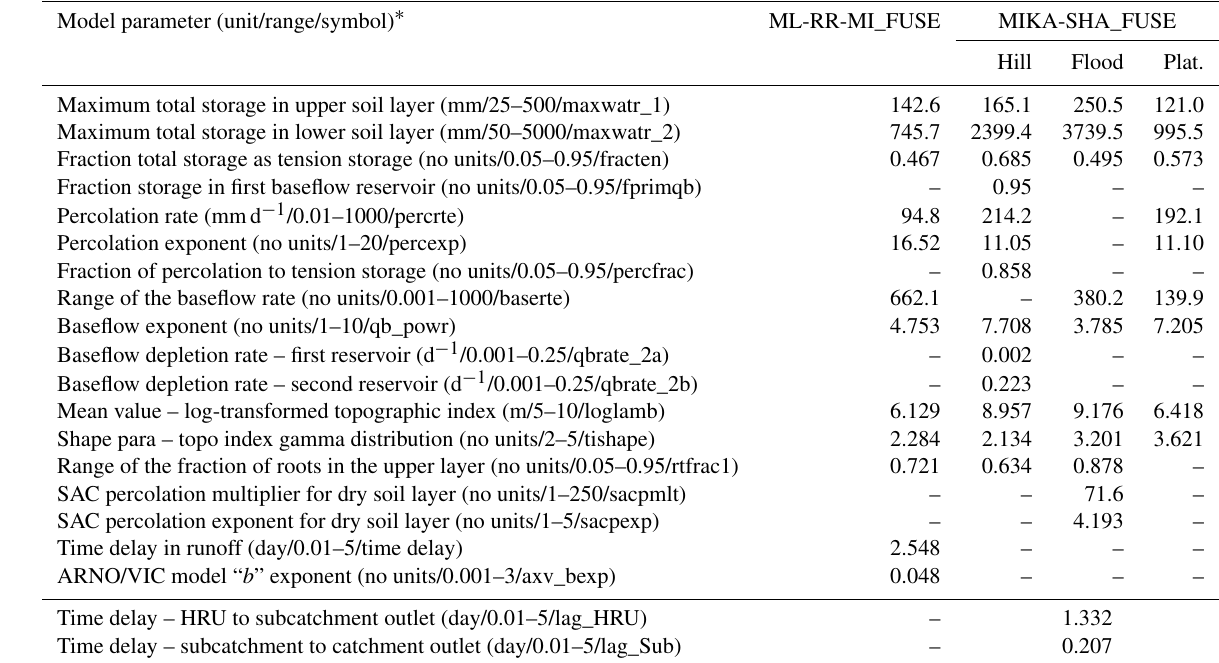
Table A2. Model parameter details of ML-RR-MI_FUSE and MIKA-SHA_FUSE. Model parameter (unit/range/symbol)